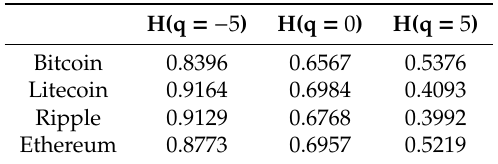
Table 2. Multifractality analysis.